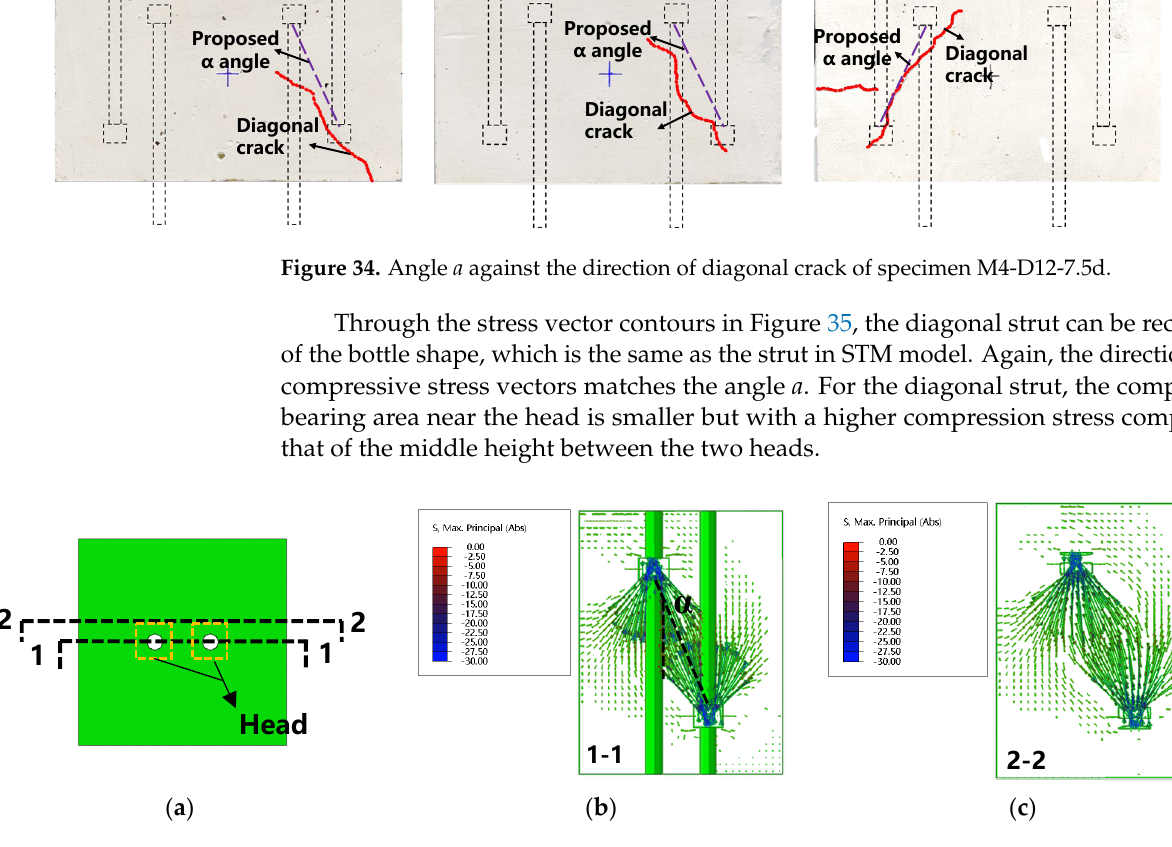
Figure 35. Compressive stress vector contours ( a ) Top view ( b ) 1-1 section ( c ) 2-2 section.